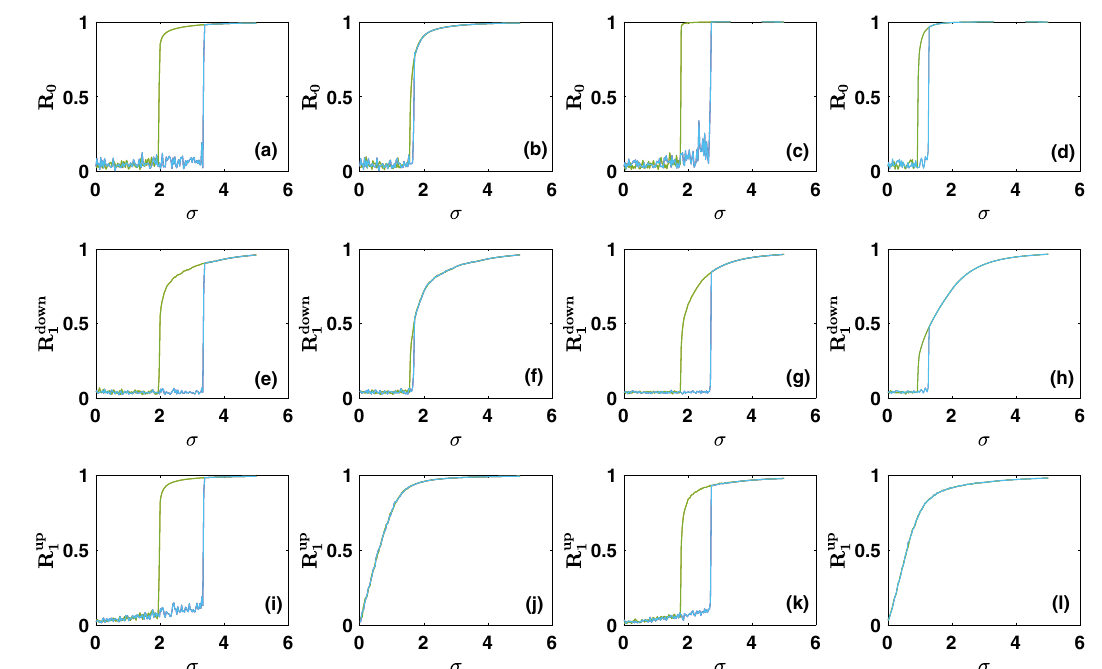
Fig. 2 The higher-order topological synchronization models coupling nodes and links on simplicial complexes. The hysteresis loop for the synchronization order parameters R 0 , R down , and R up are plotted versus σ for the higher-order topological synchronization Model Nodes-Links-Triangles 1 1 (NLT) (panels a , e , i and c , g , k ) and Model Nodes-Links (NL) (panels b , f , j and d , h , l ) de fi ned over the Network Geometry with Flavor 13 (panels a , e , i and b , f , j ) and the con fi guration model of simplicial complexes 51 (panels c , g , k and d , h , l ). The green lines indicate the backward transitions and the cyan lines indicate the forward transitions. The Network Geometry with Flavor on which we run the numerical results shown in a , b , e , f , i , j includes N [0] = 500 nodes and has fl avor s = − 1 and d = 3. The con fi guration model of simplicial complexes on which we run the numerical results shown in c , d , g , h , k , l includes N [0] = 500 nodes and has generalized degree distribution which is power-law with exponent γ = 2.8. In both Model NL and in Model NLT we have set Ω 0 = Ω 1 = 2 and τ 0 = τ 1 =